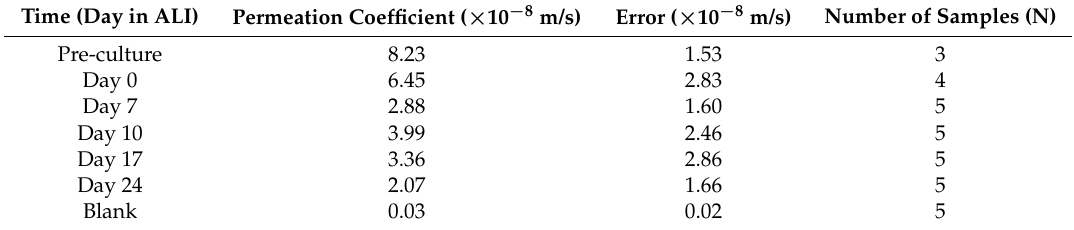
Table 2. Result of the permeation experiments with fluorescein sodium salt through the ftSE. The permeation at different times during the cultivation was investigated.